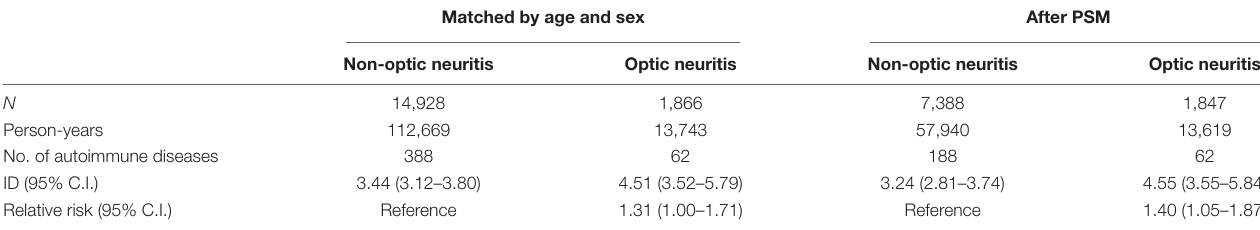
TABLE 2 | Poisson regression for the incidence and relative risk of autoimmune diseases in the optic neuritis group and non-optic neuritis group. Matched by age and sex